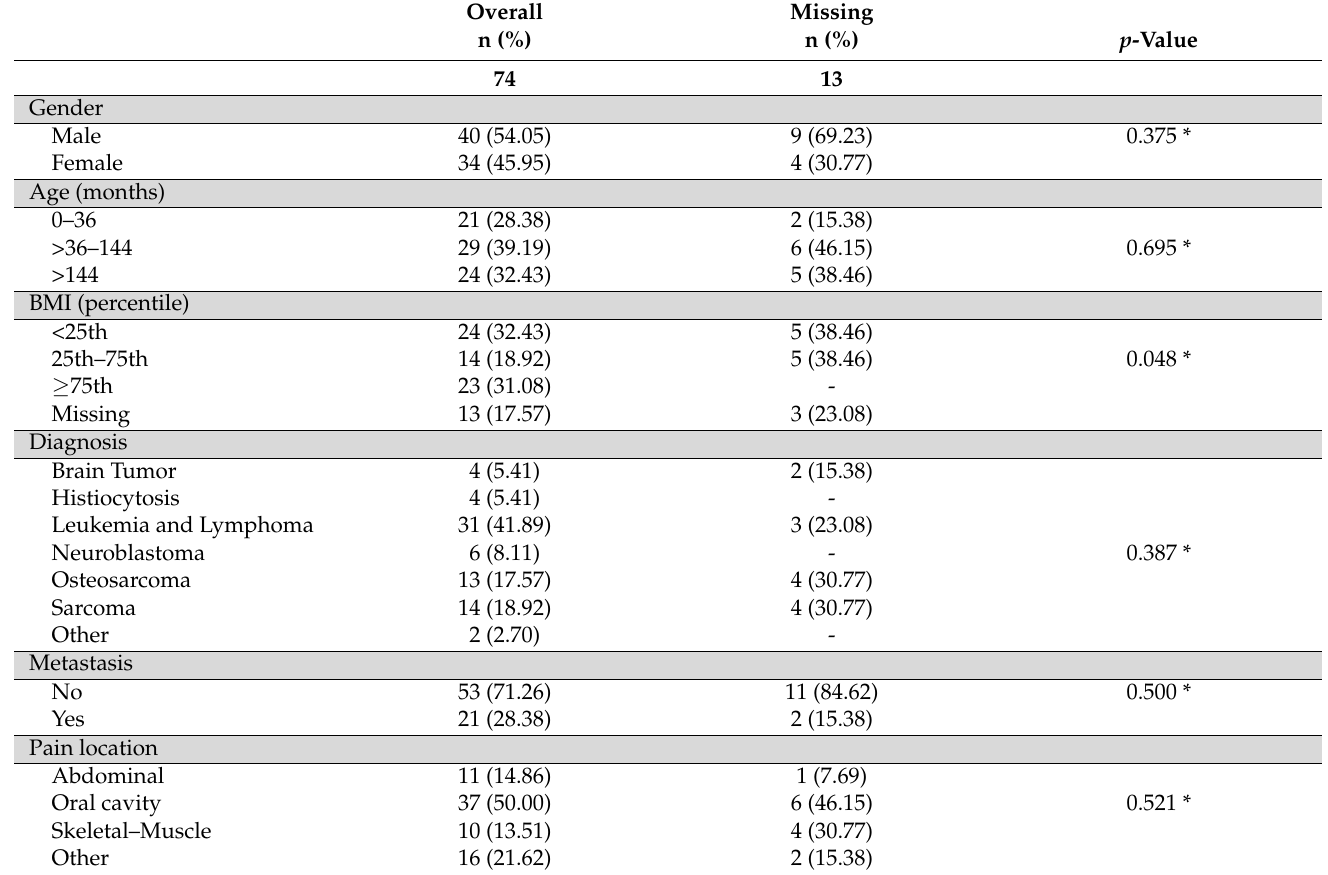
Table 1. Characteristics of STOP Pain patients and efficacy and safety parameters overall and for subjects with missing genetic